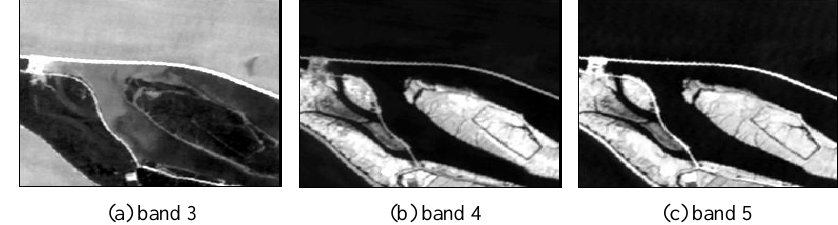
Fig. 3 Textural extraction results of 2009 remote sensing image (band 3, 4 and